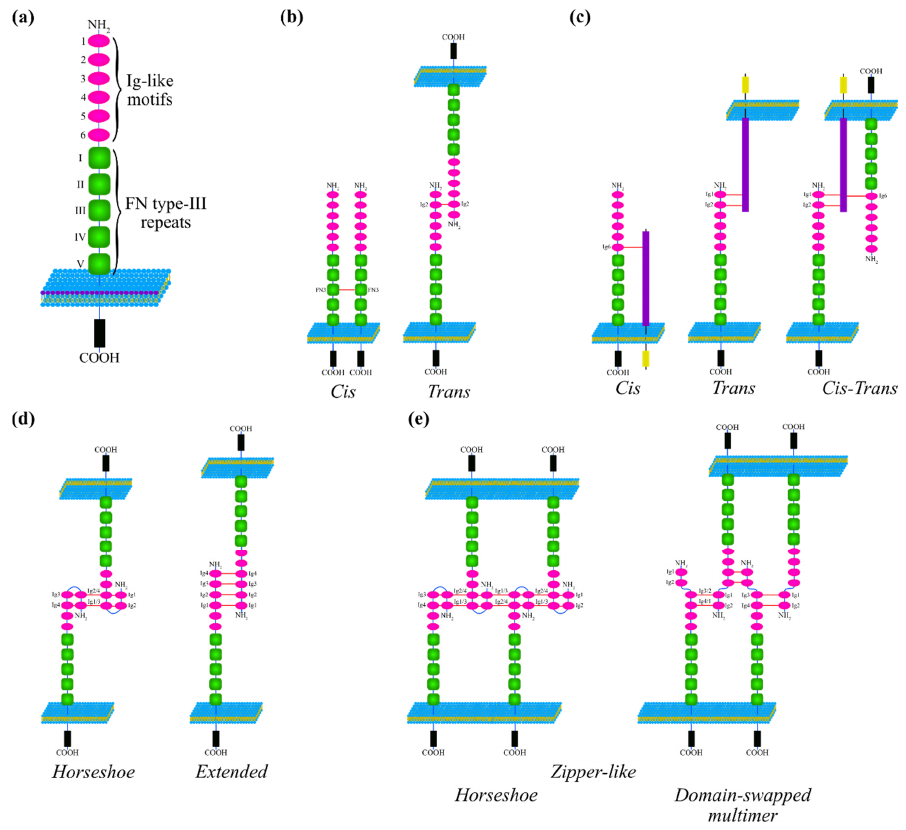
Figure 1. L1 cell adhesion molecule (L1CAM) structures and interactions. ( a ) Schematic structure of L1CAM, with the ectodomain comprising six Ig-like motifs (Ig1-Ig6, magenta ellipses) and five Fibronectin type-III repeats (FN1-FN5, green squares), the transmembrane (blue line) and the intracellular domain (black rectangle) ( b ) L1CAM homophilic interactions involve the FN3 repeat of two consecutive molecules ( cis ) that form hydrogen bonds (red line). When the molecules are exposed on two di ff erent cells, the involved residues can span between all the Ig-like motifs and FN2 or FN3 repeats ( trans ). For space limitations and clarity, only some homophilic bonds are displayed. See the main text for more details. ( c ) L1CAM heterophilic interactions involve almost all extracellular domains, with the specific domain depending on the partner. Only some examples of binding are shown here; more details are available in the main text. A generic partner is depicted as a transmembrane protein (violet rectangle: extracellular domain; yellow rectangle: intracellular domain). The two types of heterophilic interaction can be concomitant ( cis - trans ). ( d ) L1CAM can acquire di ff erent conformations during its interactions. The horseshoe structure is characterized by the bond between Ig-1 with Ig-4 and Ig-2 with Ig-3 that leads to a curvature of the molecule. Two horseshoe structures are connected by Ig-1 and Ig-2 repeats of adjacent molecules. The extended conformation involves bonds between the first four Ig structures of two neighbor L1CAM molecules. ( e ) More than two L1CAM molecules might be connected acquiring a very complex conformation (zipper-like). The domain-swapped multimer comprises interactions between Ig1 with Ig-4 and Ig2 with Ig-3. For space limitations and clarity, only interactions with full-length L1CAM are displayed. See text for more